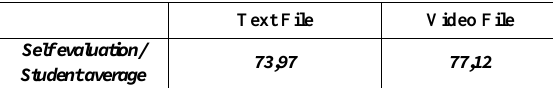
Table 5. Cognitive Residue Analysis by File